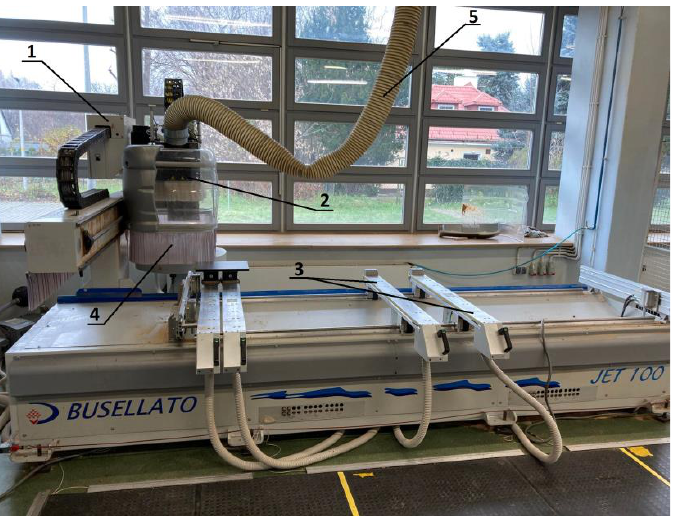
Figure 1. General view of a machining center (Busellato Jet 100), which was used in the study (1 — mobile stand, machine body element, 2 — spindle head, 3 — elements of vacuum working table, (1—mobile stand, machine body element, 2—spindle head, 3—elements of vacuum working table, 4 — spindle dust brushes, 5 — dust extraction system pipe). 4—spindle dust brushes, 5—dust extraction system